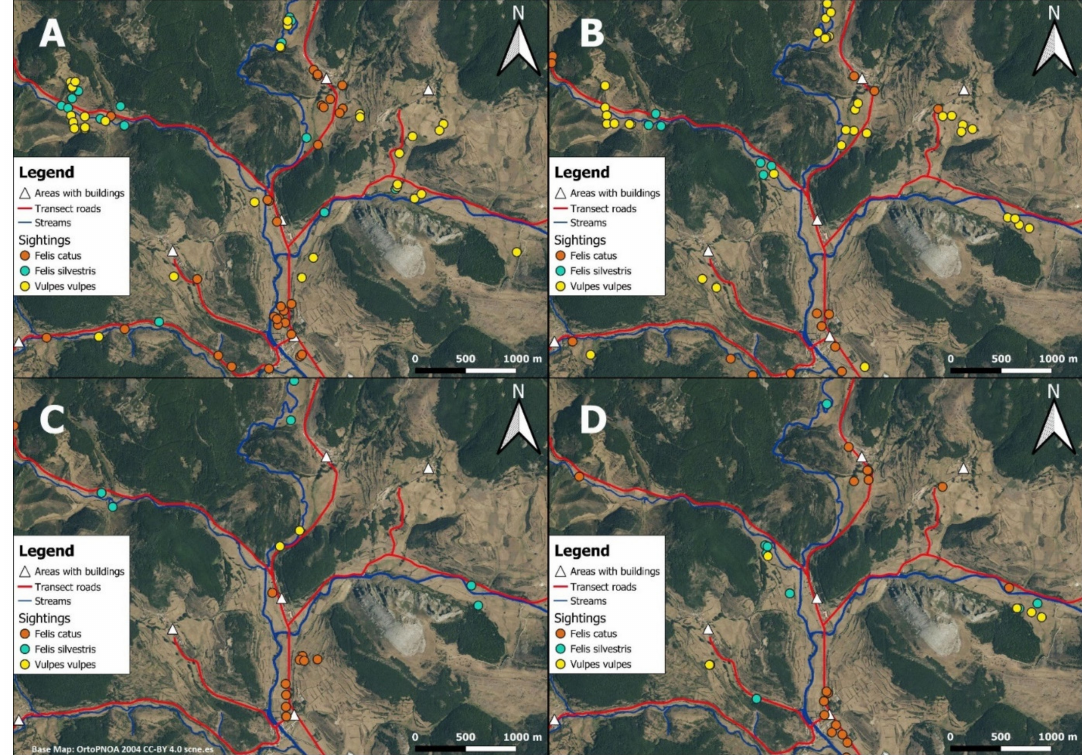
Figure 3. Distribution in pastures of domestic cats, European wildcats and red foxes in 2016 ( A ), 2017 ( B ), 2018 ( C ) and 2019 ( D ) in a central section of the study area. As a rule, dark and cleared areas represent forests and pastures,